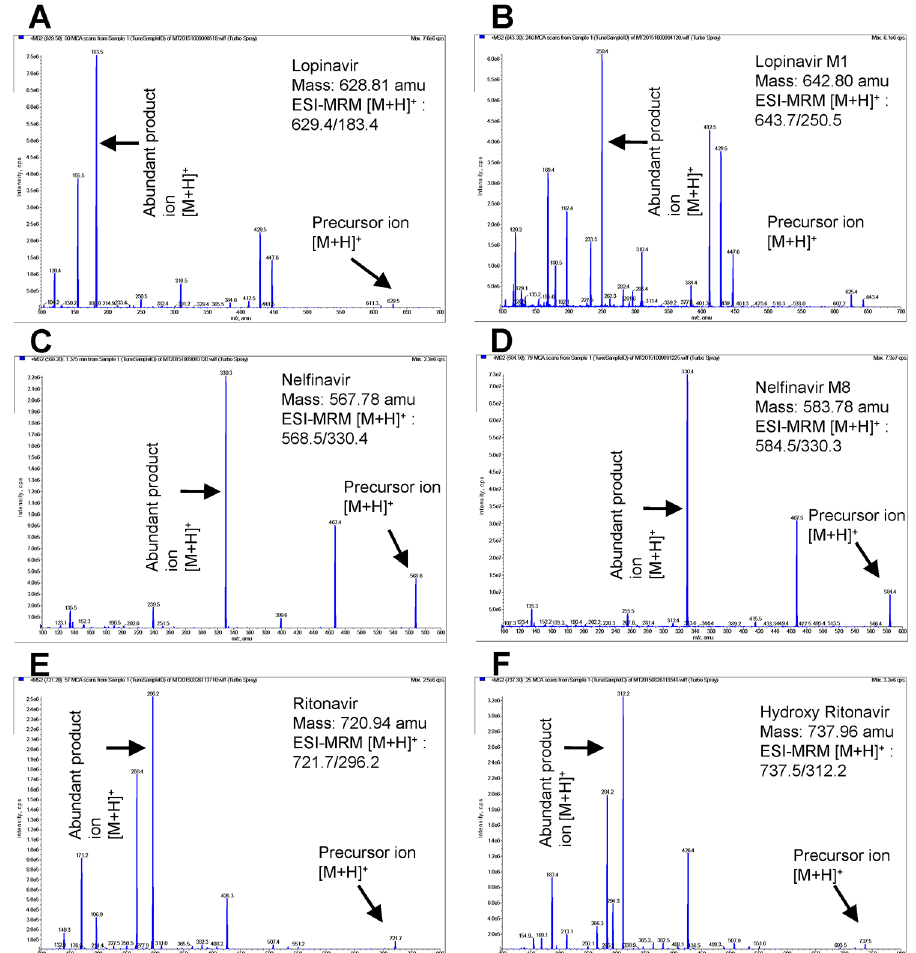
Fig 1. Development of LC-MS/MS methods to quantitate lopinavir, lopinavir M1, nelfinavir, nelfinavir M8, ritonavir, and hydroxy ritonavir in human liver microsomes. MS/MS spectra of (A) lopinavir, (B) lopinavir M1, (C) nelfinavir, (D) nelfinavir M8, (E) ritonavir, (F) hydroxy ritonavir with ESI proton adducts [M +H] + in positive mode. The y-axis shows intensity (CPS, count per second) and the x-axis shows the mass to charge ratio (m/z,